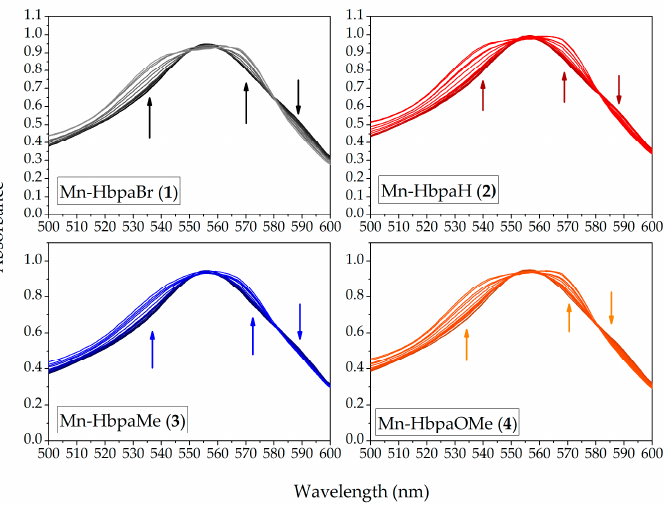
Figure 11. UV-Vis spectrum variation of deoxymyoglobin (Mb) upon CO release promoted by compounds ( 1 ) – ( 4 ) in PBS (0.1 mol L − 1 , pH = 7.4) during UV light excitation ( λ em = 395 ± 5 nm). ( 1 )–( 4 ) = 2.00 × 10 − 5 mol L − 1 .